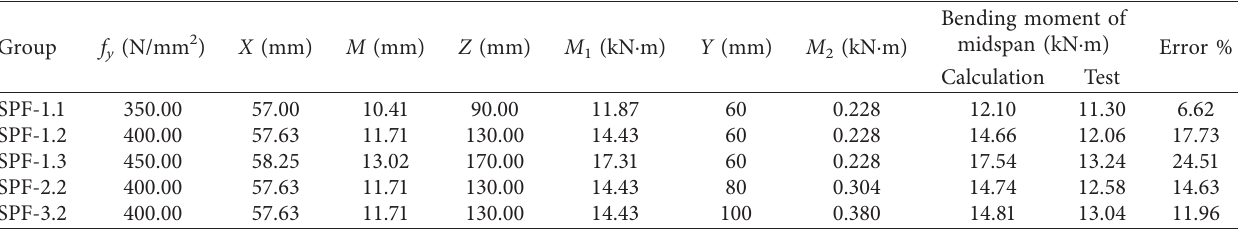
Bending moment of midspan (kN · m) Error % Calculation Test